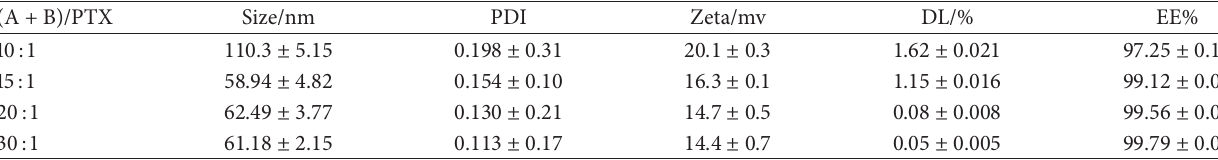
Table 1: Data of PTX liposome when mass ratio of A/B is 1:9.